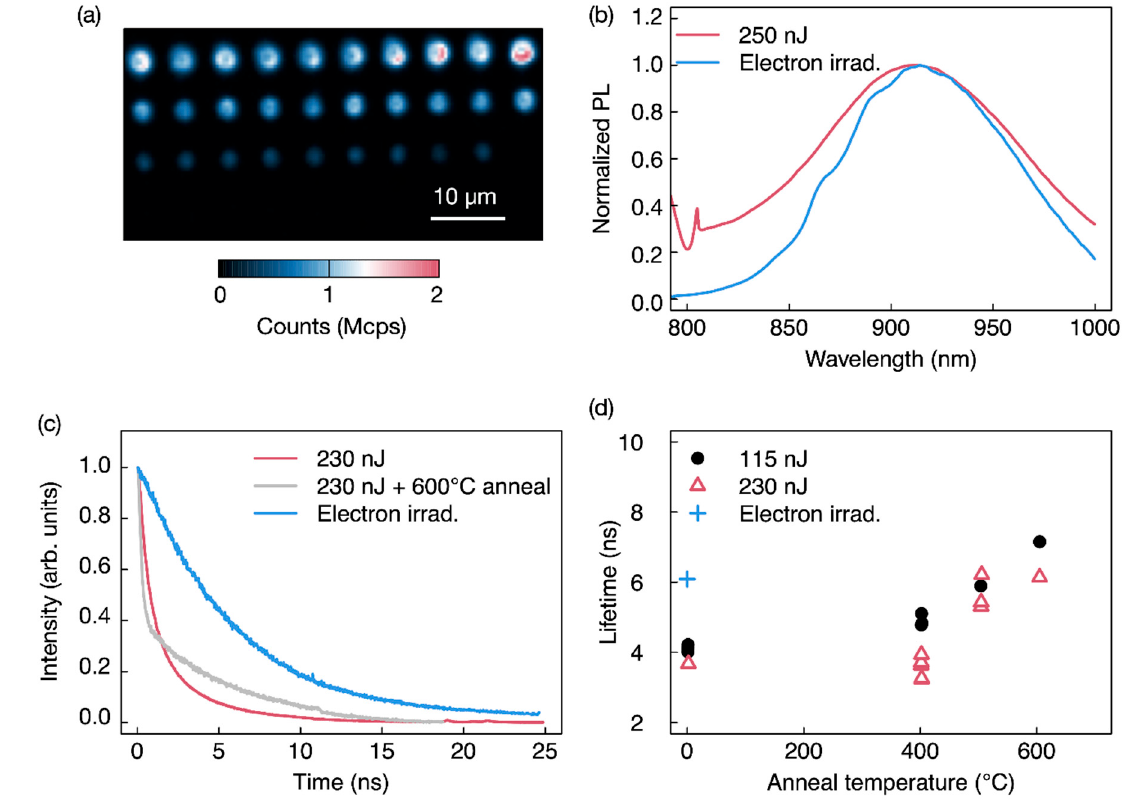
Figure 7. Semi-insulating unintentionally doped 4H-SiC laser written close to the surface using 1030 nm fs laser after 400 °C annealing. ( a ) Confocal excitation 730 nm, DM 785 nm, and long pass filter at 850 nm; the bright spots are associated to V Si . ( b ) Room temperature PL of the 230 nJ laser written spot compared to an electron-irradiated sample. A spectral broadening and shift are observed for the laser written emission. Excitation is at 785 nm, and collection is above 800 nm. ( c ) Exemplary lifetime decay for the dots fabricated at 230 nJ with no annealing and 600 °C annealing, compared to an electron-irradiated PL lifetime in a similar substrate. ( d ) Lifetime of the emission at the laser fabricated area versus annealing temperature.